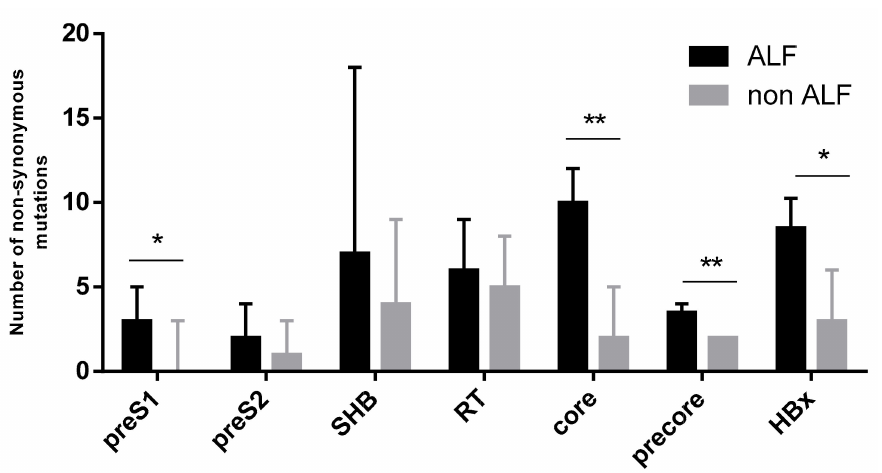
Figure 3. The SHB, preS1, preS2, RT, precore, core, and HBx regions were NGS sequenced. Results are presented as the medians (interquartile range) of the number of nonsynonymous mutations in each region of the patient sequences when compared with a genotype-specific reference sequence.